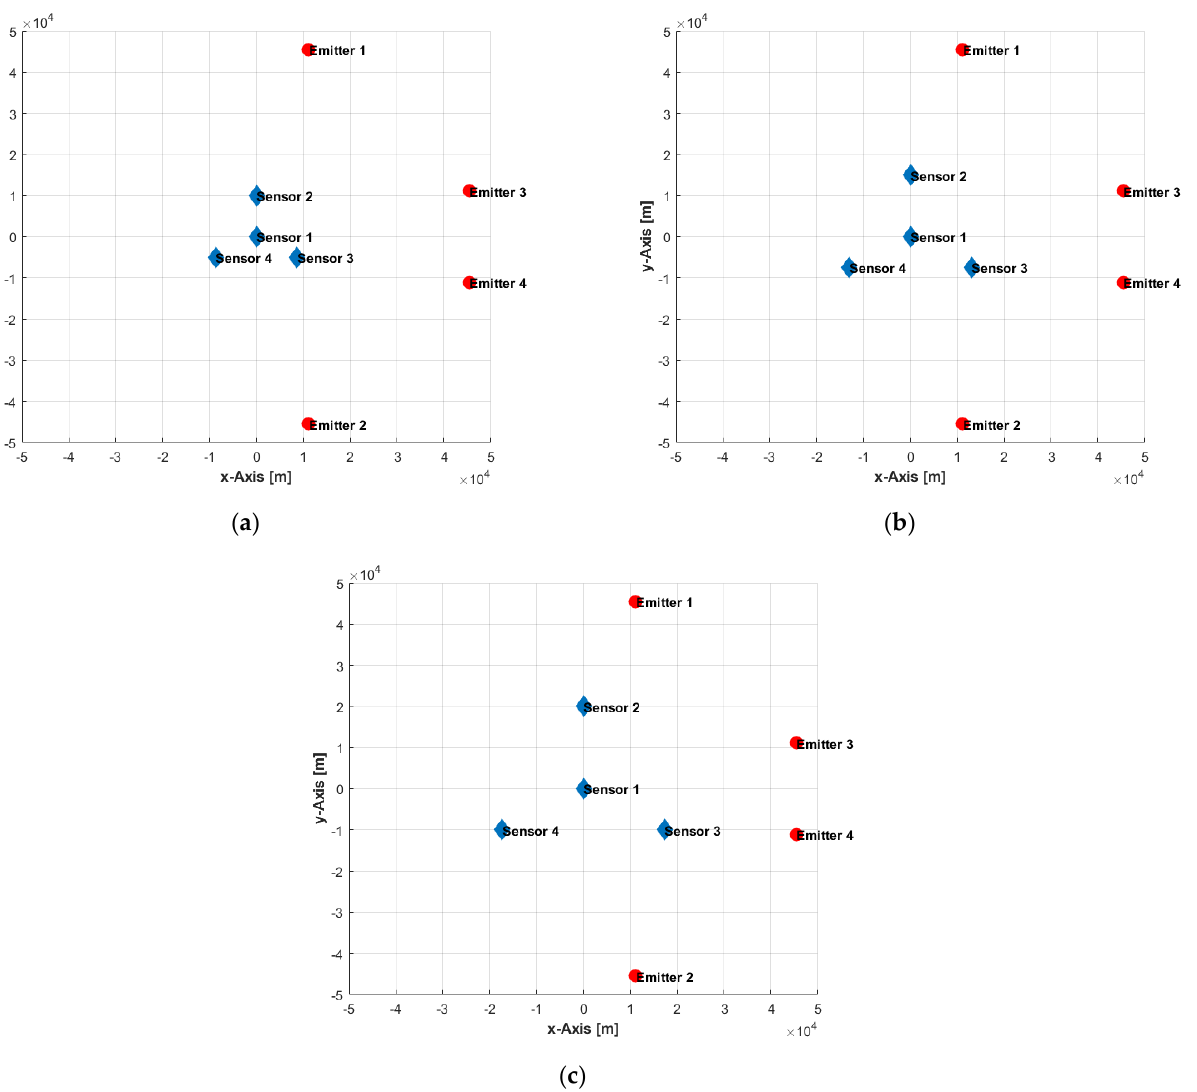
Figure 6. Sensors-emitters geometry with various baselines of: ( a ) 10 km; ( b ) 15 km; ( c ) 20 km.